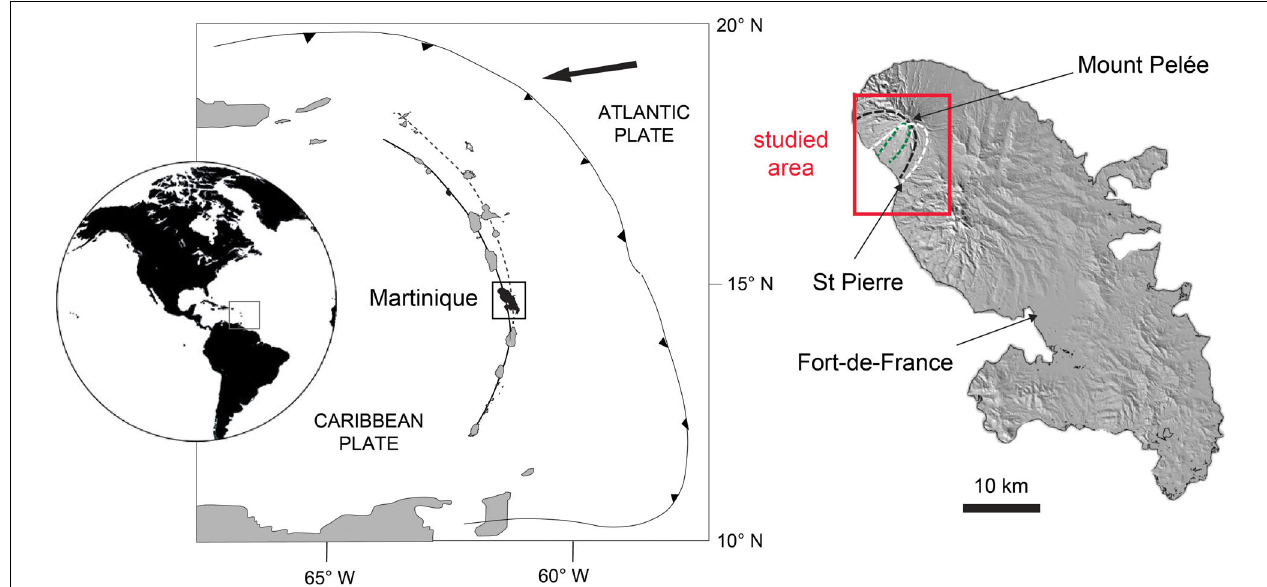
FIGURE 1 | Regional setting of Martinique Island in the central part of the Lesser Antilles. The dashed line north of Martinique represents the Oligocene arc front, the bold line represents the Plio-Pleistocene arc front. The black arrows point in the direction of subduction of the Atlantic plate beneath the Caribbean Plate. The Mount Pelée volcano is located in the northern part of the island, and the study area is within the red rectangle, described in Figure 2 . The dashed lines within the study area refer to imbricate horseshoe-shaped structures left by flank collapses of the volcano 125, 25, and 9 ka ago (Le Friant, 2003; Boudon et al., 2007; Germa et al.,